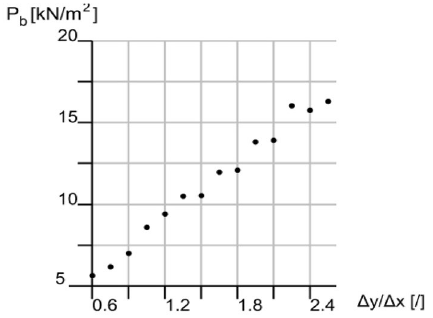
Figure 16. Variation of the buckling load for increasing ratios